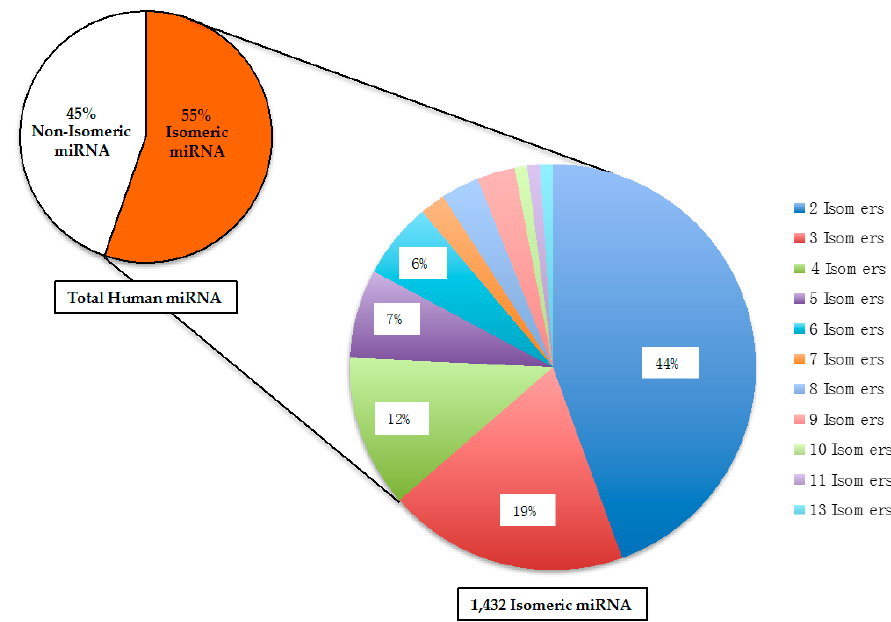
Figure 2. Distribution of isomeric and non ‐ isomeric human mature microRNA. Isomeric microRNA are defined as having identical nucleotide composition, but different RNA sequences. In total, there are 2,588 human microRNA.